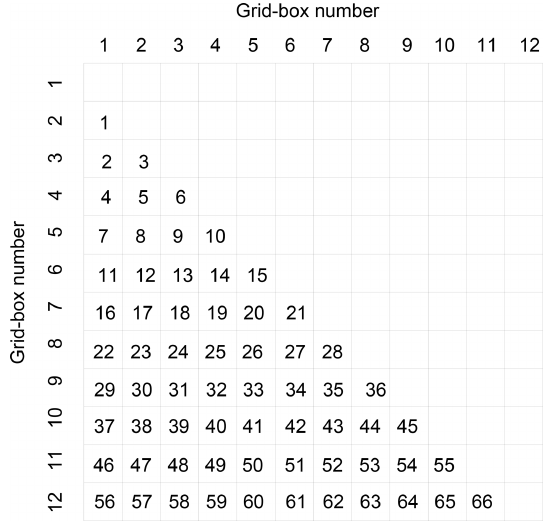
Figure 2. The numbering of individual pairs of grid boxes. The fig- ure depicts the correlation matrix, the orders of rows and columns correspond to the grid box labels from Fig. 1. The sub-diagonal part of the (symmetrical) matrix was used for the numbering of individ- ual pairs of grid boxes – the numbers inside of the matrix represent the identifiers used in Fig.